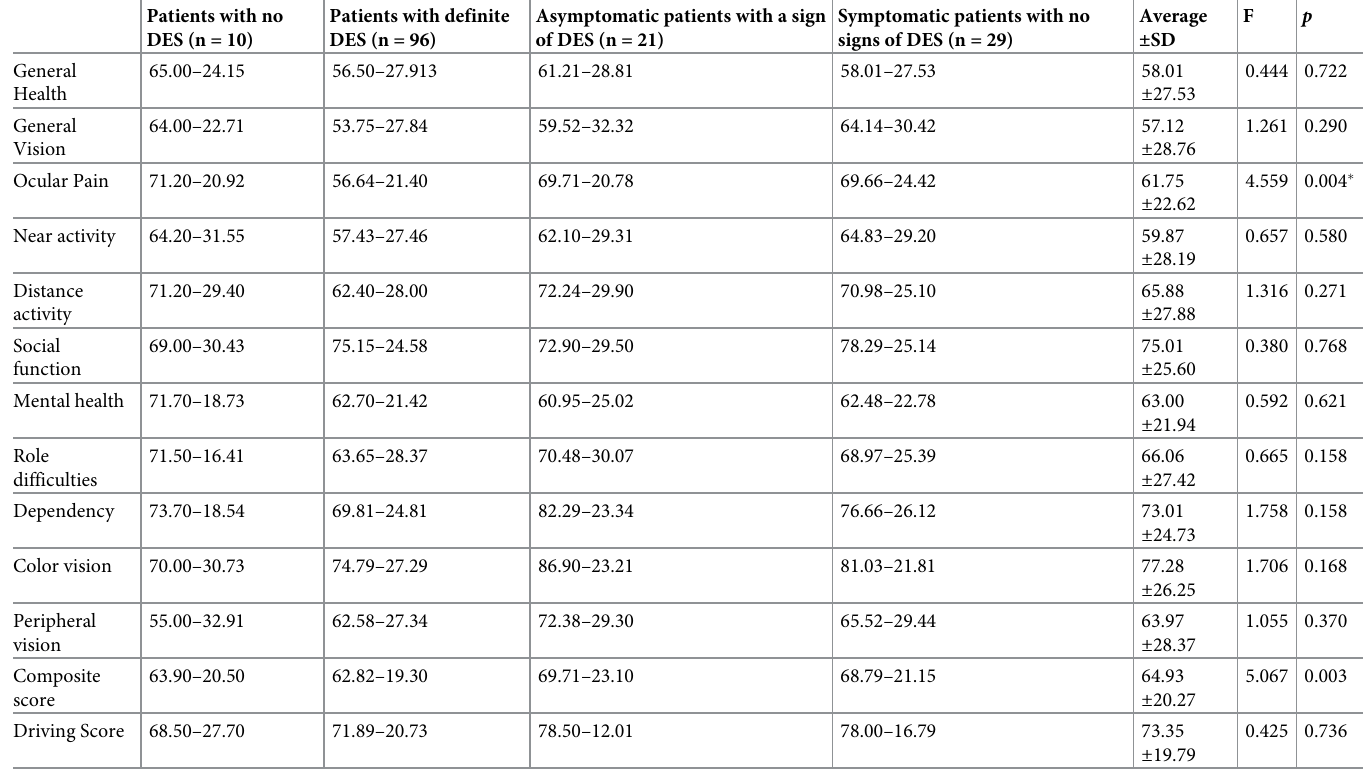
Table 3. The mean scores ± SD and the analysis of the composite score and each subscale score of the NEI VFQ-25 among the four sub-groups. Patients with no DES (n = 10)